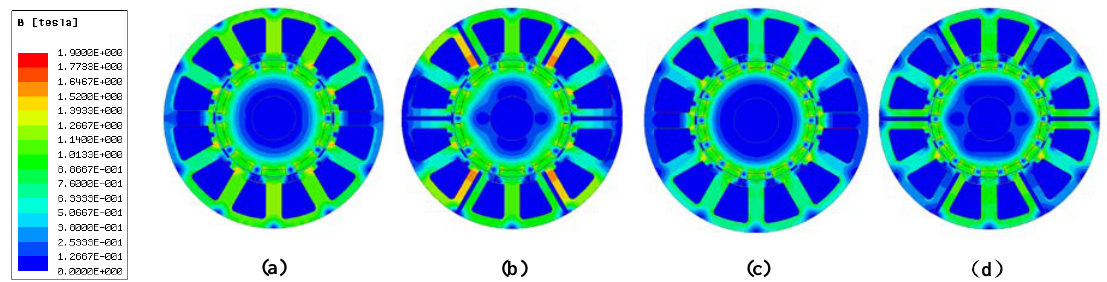
Figure 6. Flux density distribution of the four machines. ( a ) 12s / 10p integral machine; ( b ) 12s / 10p E-core modular machine; ( c ) 12s / 14p integral machine; ( d ) 12s / 14p E-core modular machine.